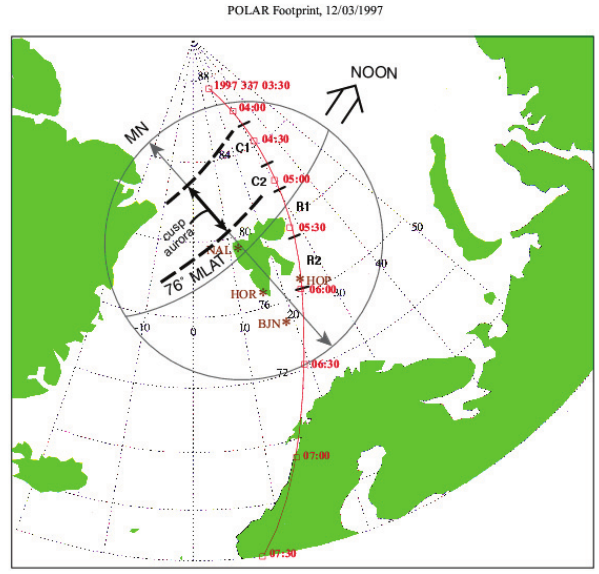
Fig. 2. Map showing the trajectory of Polar’s magnetic foot- point relative to observatories around Svalbard. Also shown is the approximate region where cusp aurora was observed from Ny